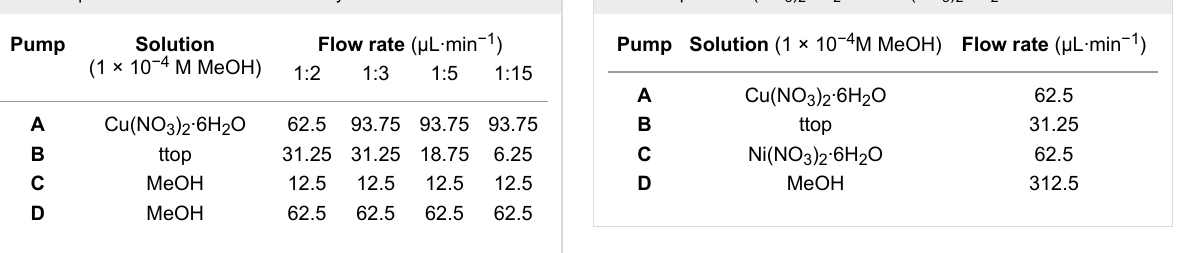
Table 1: An overview of the solutions and flow rates used for the reac- tions of ttop and Cu at different stoichiometry.